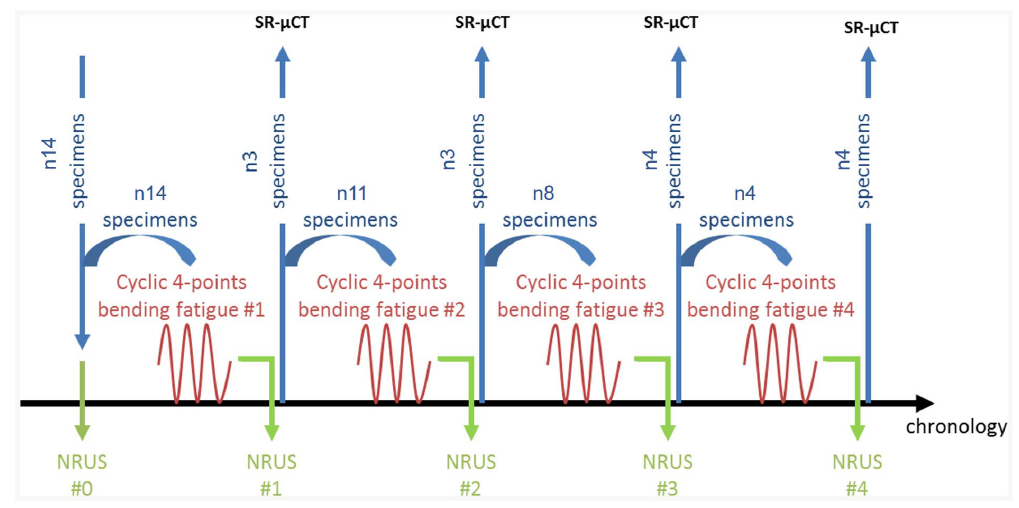
Figure 1. Diagram illustrating the experimental protocol.